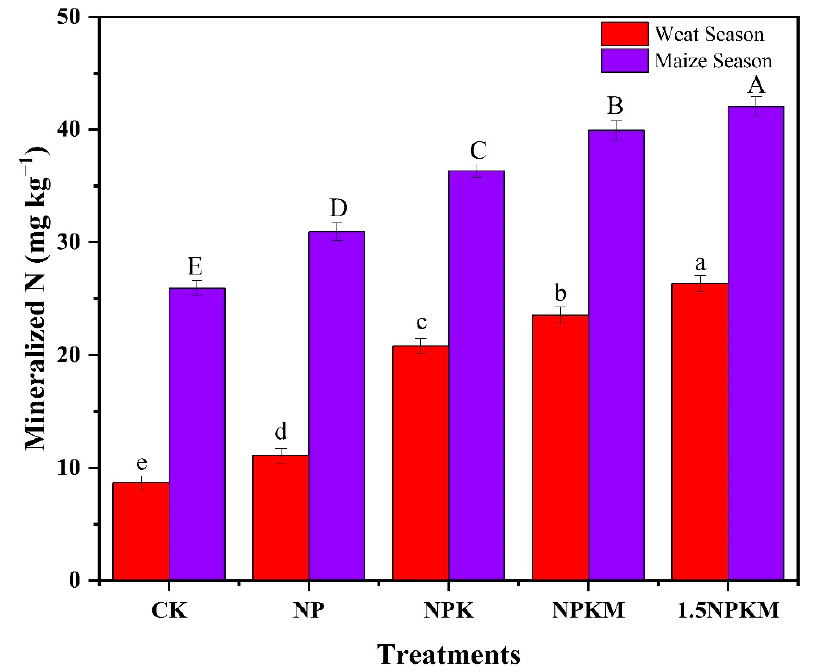
Figure 4. Availability of mineralized N to wheat and maize during the whole growing period. Capital